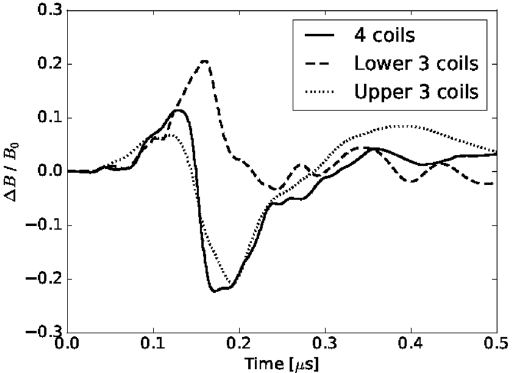
Figure 2. The time evolution of the magnetic field measured with the B-dot probe using all four coils, the lower three coils (top coil is turned off), and the upper three coils (bottom coil is turned